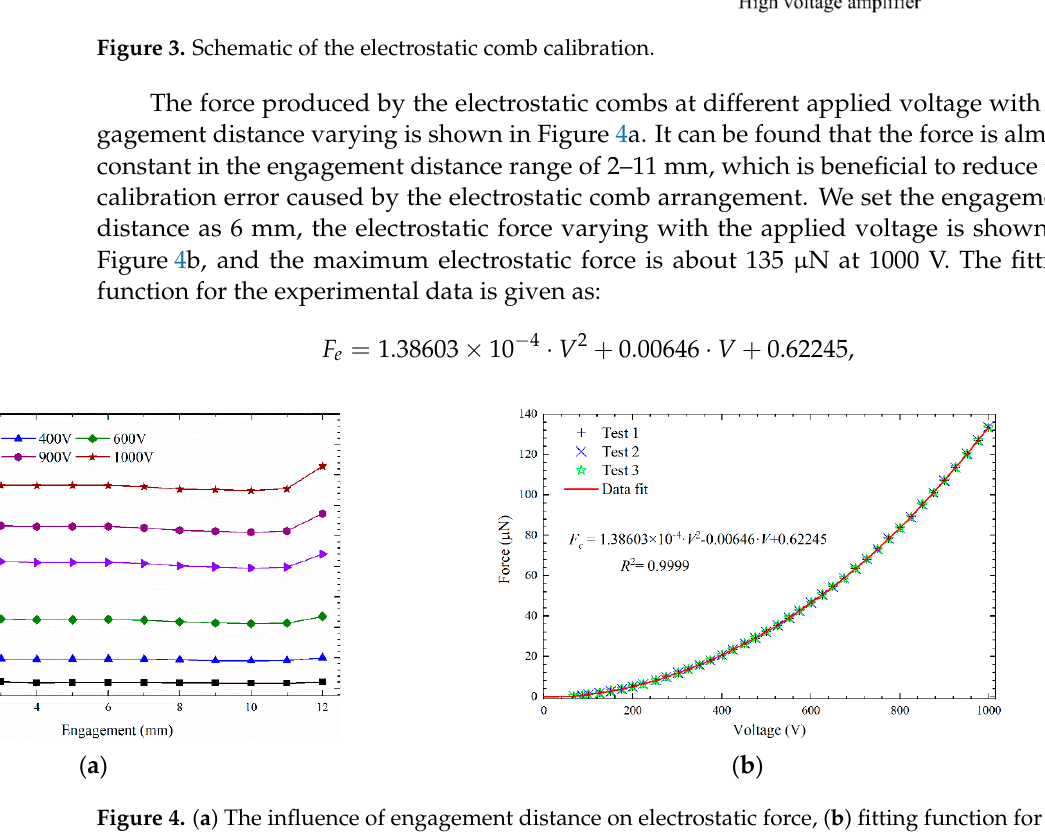
Figure 3. Schematic of the electrostatic comb calibration.